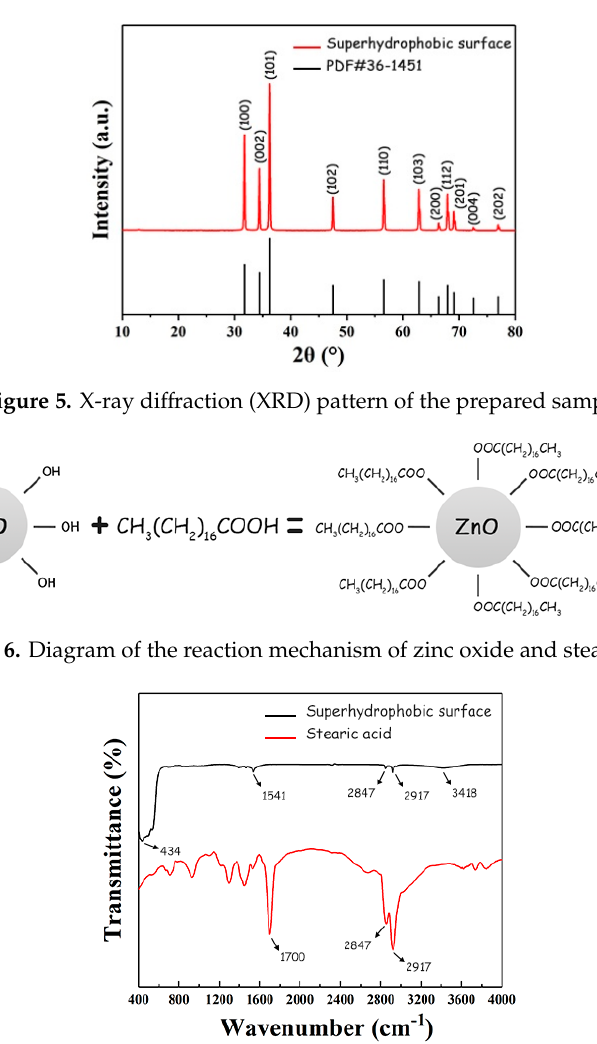
Figure 7. Fourier transform infrared (FTIR) spectrum of the prepared sample.